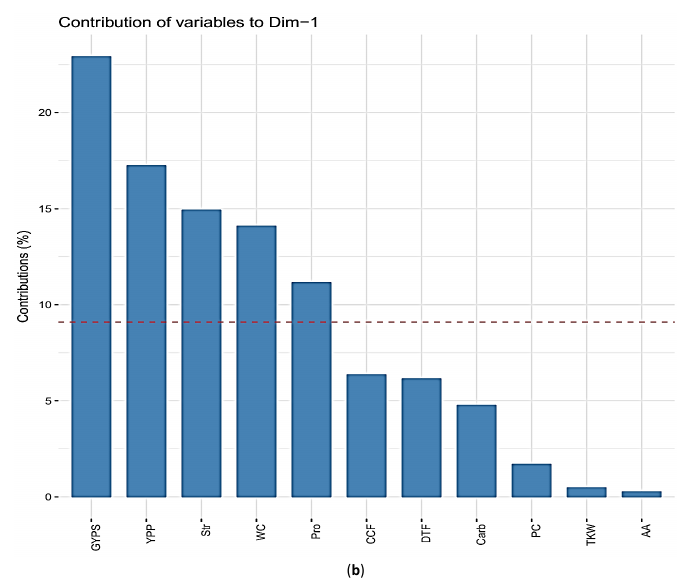
Figure 3. ( a ) Principal component analysis for the percentage changes of the traits in barley under heat stress during flowering and seed set. Traits names, abbreviations, and measurements are listed in Table 1; ( b ) the percentage contribution of each trait in the principal component biplot dimension 1 for the traits in barley under heat stress during flowering and seed